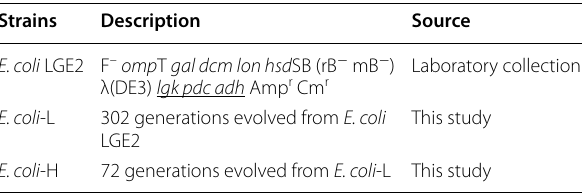
Underlined regions represent heterologous